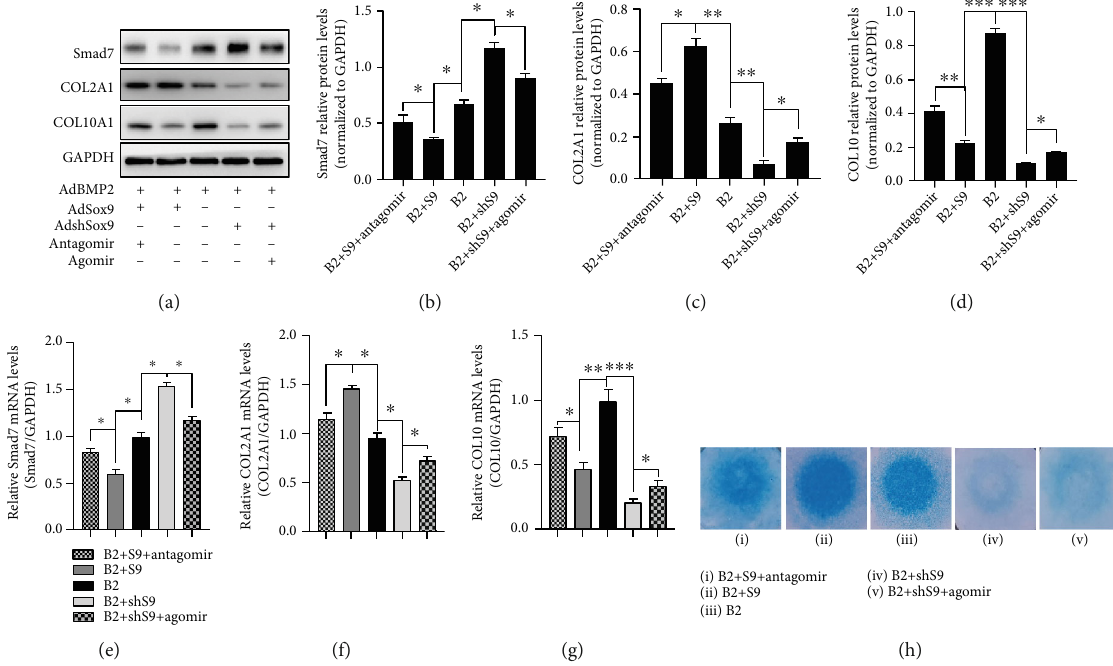
Figure 6: BMP2-induced chondrogenesis was enhanced by miR-322-5p. (a – d) WB revealed that overexpression of miR-322-5p inhibited expression of Smad7 and COL10A1 and promoted that of COL2A1; silencing of miR-322-5p brought the opposite changes. (e – g) Results of qPCR mimicked those of WB. (h) Alcian Blue staining supported the e ff ect of miR-322-5p in facilitating BMP2-induced chondrogenesis. ∗ p < 0 : 05 , ∗∗ p < 0 : 01 , and ∗∗∗ p < 0 : 0001 . B2: BMP2; S9: Sox9; shS9: shSox9.